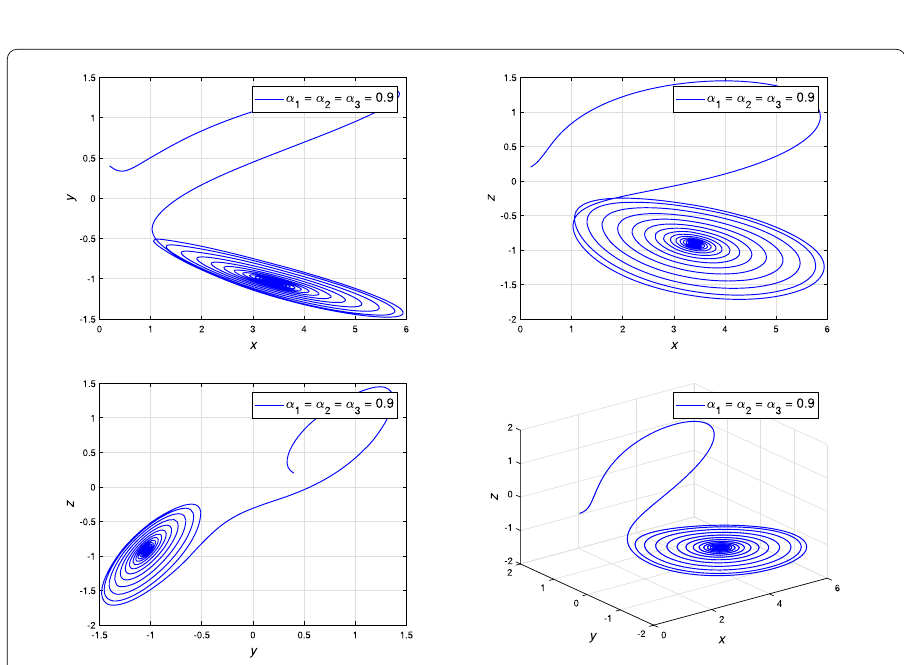
Figure 4 State variables of the fractional-order model (21) in the phase-plane ( α i = 0.9, i =